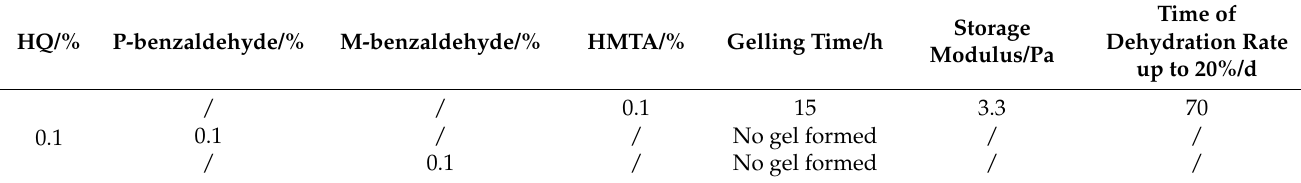
Table 2. Effect of type of aldehyde crosslinking agent on gel